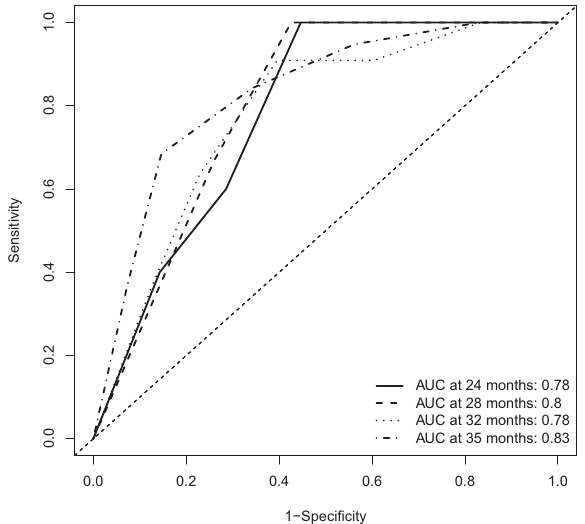
Fig. 5 Time-dependent receiver-operating curve for prediction of dyskinesia in patients with Parkinson ’ s disease. AUC Area under